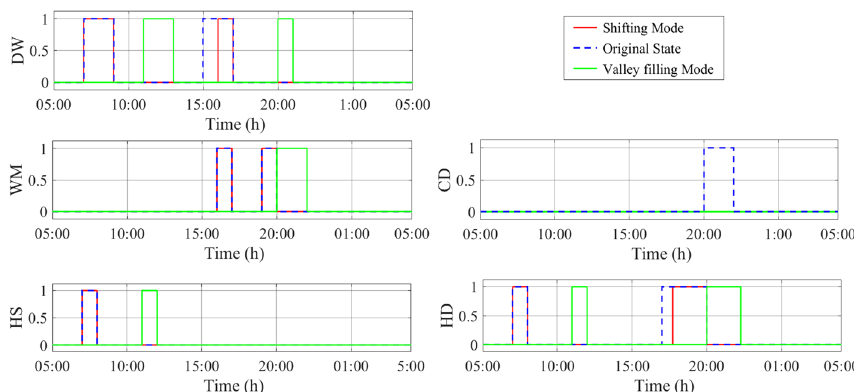
Fig. 11 Operating status of shiftable appliances case